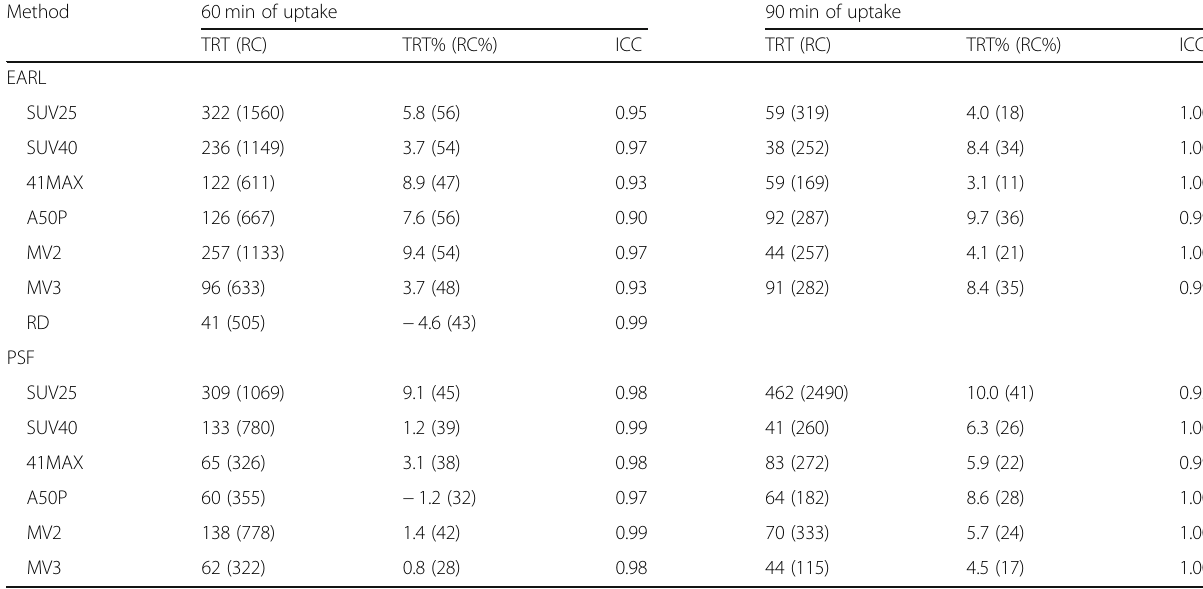
Table 5 Total tumour burden repeatability for different tracer uptake intervals, reconstruction settings, and lesion delineation methods Method 60 min of